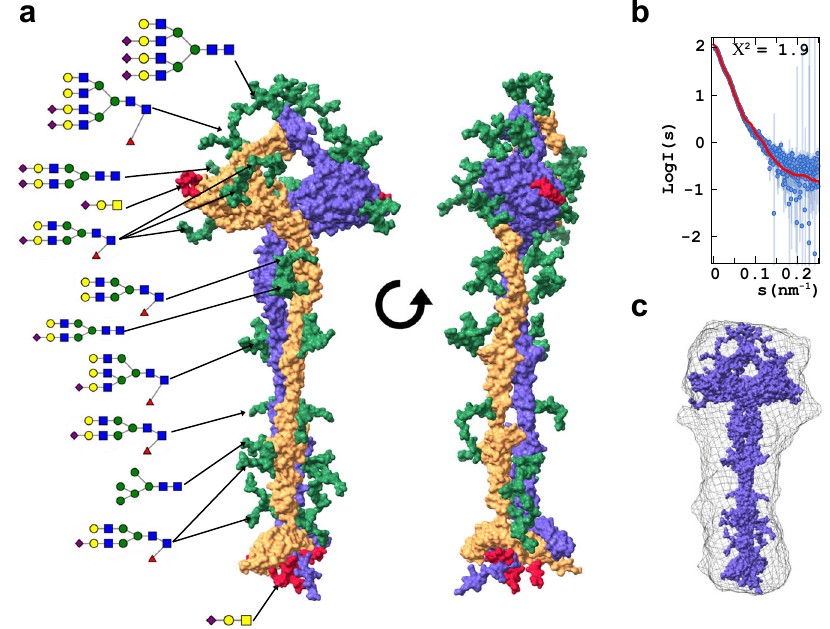
b Comparison between calculated scattering curve from the complete MUC2-C as in a (red line) and the experimental SAXS (blue circles). c SAXS ab initio averaged model of compared as a grey cloud with the fi nal model (a)